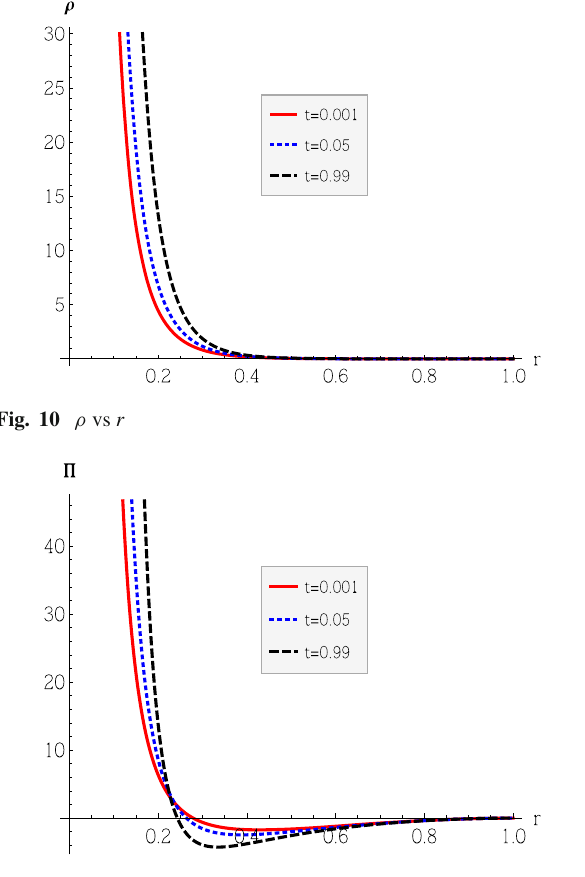
Fig. 11 p θ − p r vs r